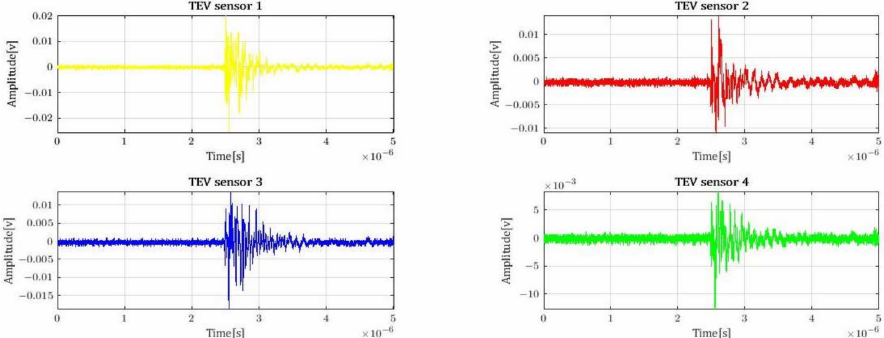
Figure 4. An example of time domain waveform of the PD signals generated at PD source